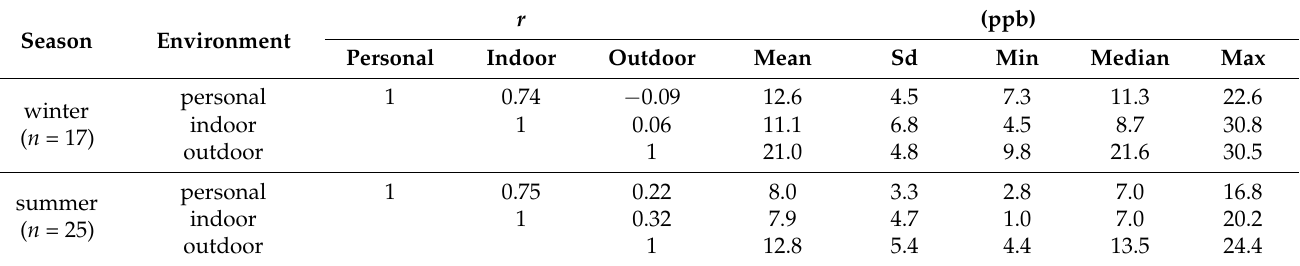
Table 3. Descriptive statistics and correlations of personal, indoor, and outdoor NO 2 by season.